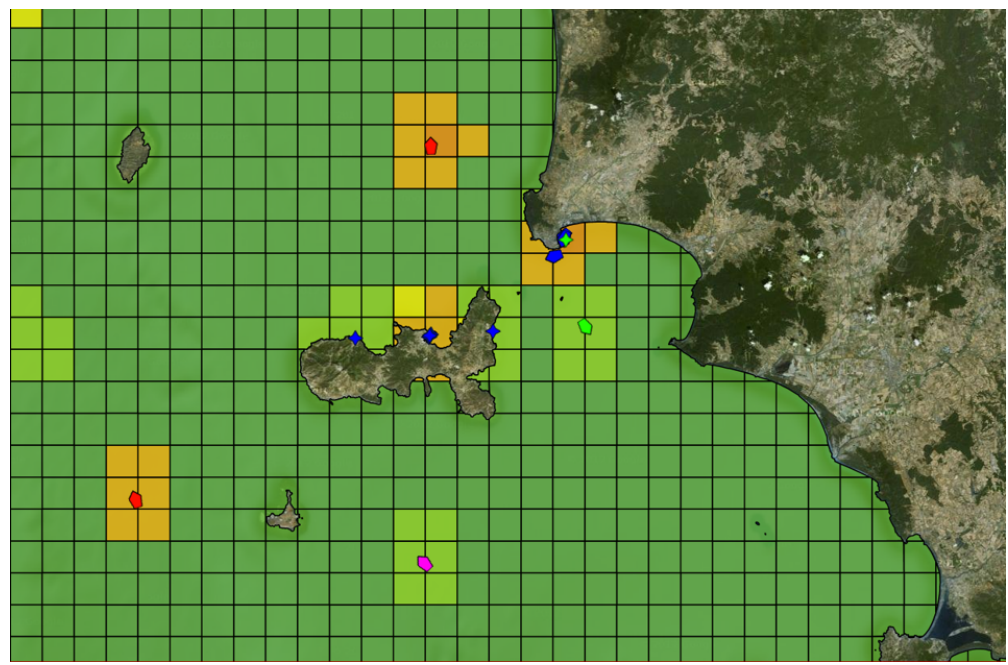
Figure 2. The dynamic risk map shown; the squares of the grid have dimension 4 by 4